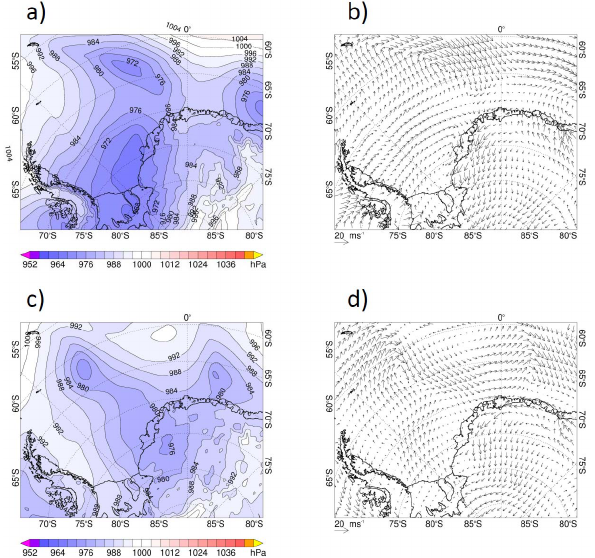
Fig. 7. ERA-Operational meteorological maps around the Weddell Figure 7. ERA ‐ Operational meteorological maps around the Weddell Sea region at various times 602 Sea region at various times during the major October ozone deple- during the major October ozone depletion event. a) mean sea level pressure (mslp) at midnight at 603 tion event. (a) Mean sea level pressure (mslp) at midnight at the the start of 7 th October; b) 10 ‐ m wind vectors at midnight at the start of 7 th October; c) mean sea 604 level pressure (mslp) at noon on 8 th October; b) 10 ‐ m wind vectors at noon on 8 th October 605 start of 7 October; (b) 10-m wind vectors at midnight at the start of 7 October; (c) mean sea level pressure (mslp) at noon on 8 October; (b) 10-m wind vectors at noon on 8 October.